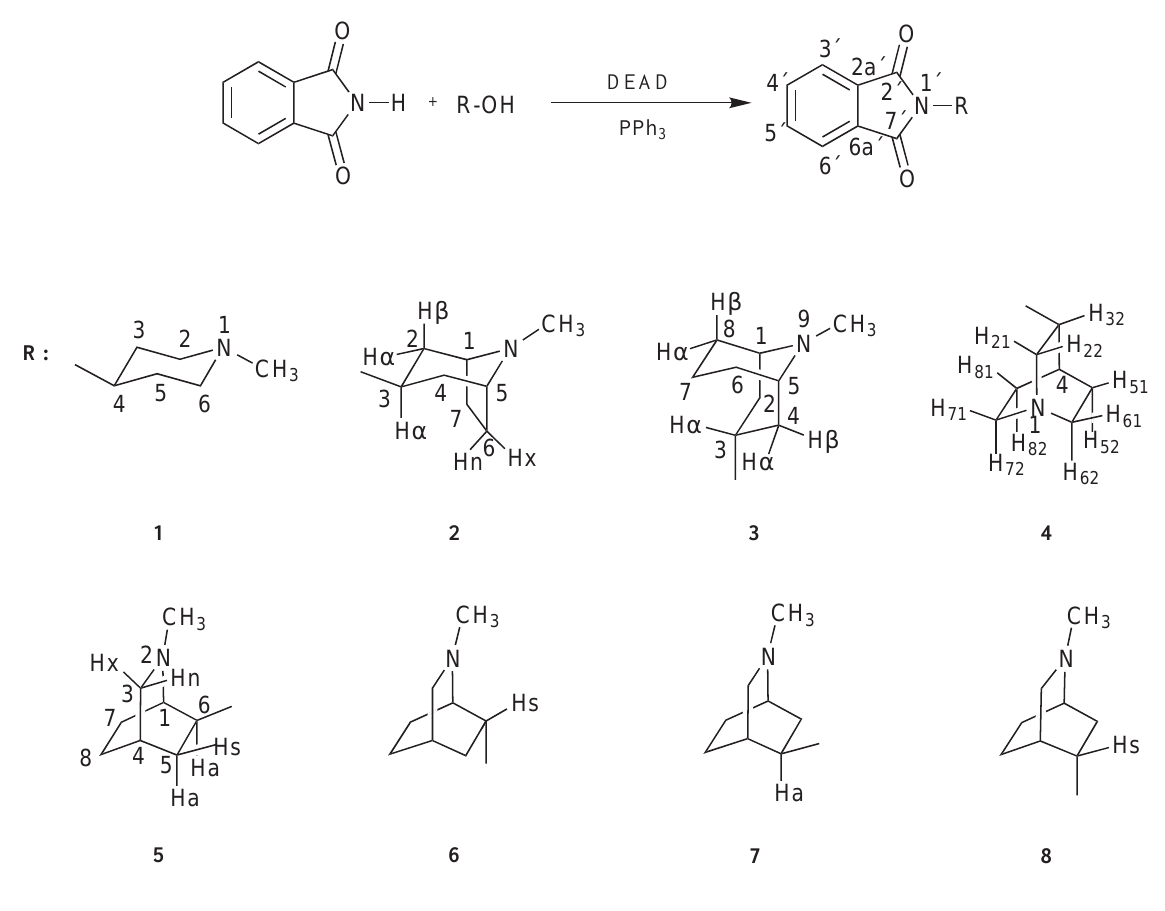
Fig. 1 Synthesis of phthalimides 1-8